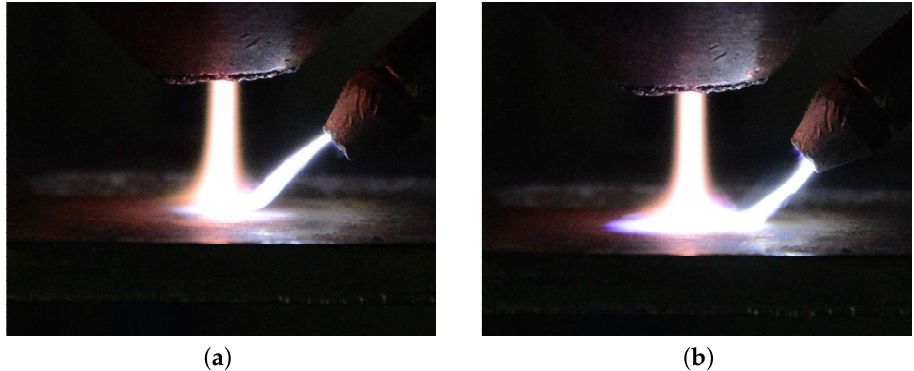
Figure 10. Pictures of two positions of the plasma bridge start at the injector outlet: ( a ) at the upper side and ( b ) at the bottom side. Other conditions as in Figure